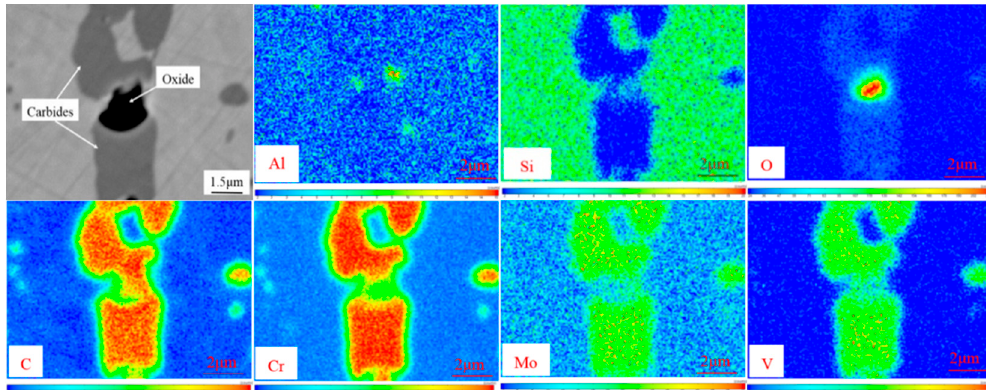
Figure 6. Carbides and oxides elemental maps of sample B.